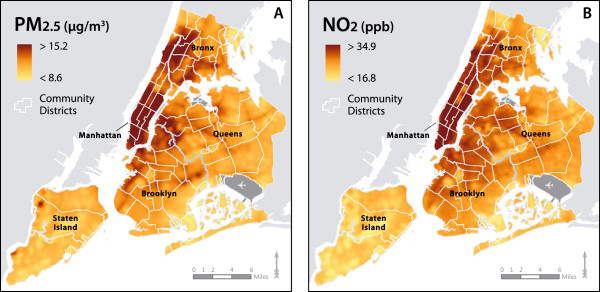
Map of spatial (KED) estimates for PM2.5 and NO2.